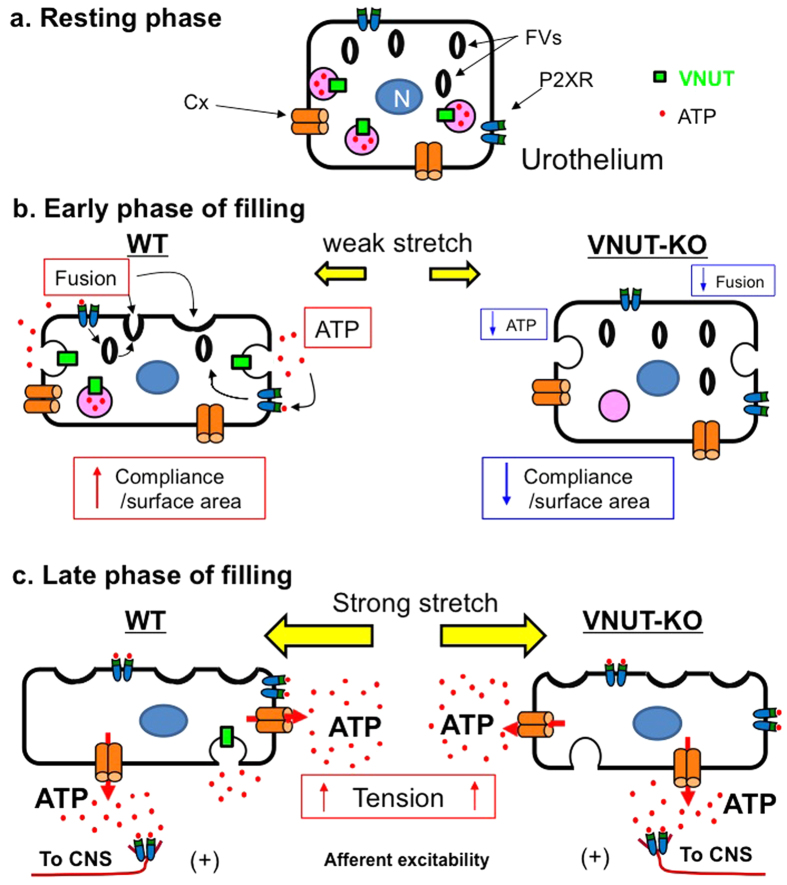
A model showing bladder function mediated by urothelial release of ATP in each bladder-filling phase.(a) Resting phase of bladder urothelium. ATP accumulates in vesicles with VNUT. Fusiform vesicles are abundant in the cytoplasm. Connexin (Cx) and P2X receptors (P2XR) are located on the urothelial cell. For simplicity, multiple layers of urothelium, bladder smooth muscle, suburothelial interstitial cells or myofibroblasts, other receptors and transmitters including urothelium-derived inhibitory factor have been omitted. (b) During the early phase of bladder filling, small increases in intravesical pressure and bladder distension stimulate a VNUT-mediated release of ATP from the urothelium. This ATP acts via an autocrine mechanism that induces fusion of fusiform/discoidal vesicles (FDVs) with the urothelial plasma membrane to increase the surface area. These mechanisms lead to increase in bladder compliance and lower intravesical pressure during filling. (c) The late filling phase produces greater increases in intravesical pressure and increased FDVs fusion with the plasma membrane. This is accompanied by a reduction in cytoplasmic FDVs numbers, stimulating further ATP release from the urothelium. In this phase, ATP release may occur through multiple mechanisms involving Cx hemichannels and vesicular release. The greater amount of ATP released stimulates P2 receptors on interstitial cells or myofibroblasts or afferent nerves. This process increases nerve firing and the information transmission about bladder filling to the central nervous system, where bladder filling sensations are triggered. In VNUT-KO mice, elimination of VNUT-mediated ATP release during the early phase of bladder filling reduces putative mechanisms that increase bladder compliance. This process then reduces compliance and leads to increase in muscle and/or mucosal tension, which in turn leads to increased afferent nerve firing and bladder sensations at a lower volume.